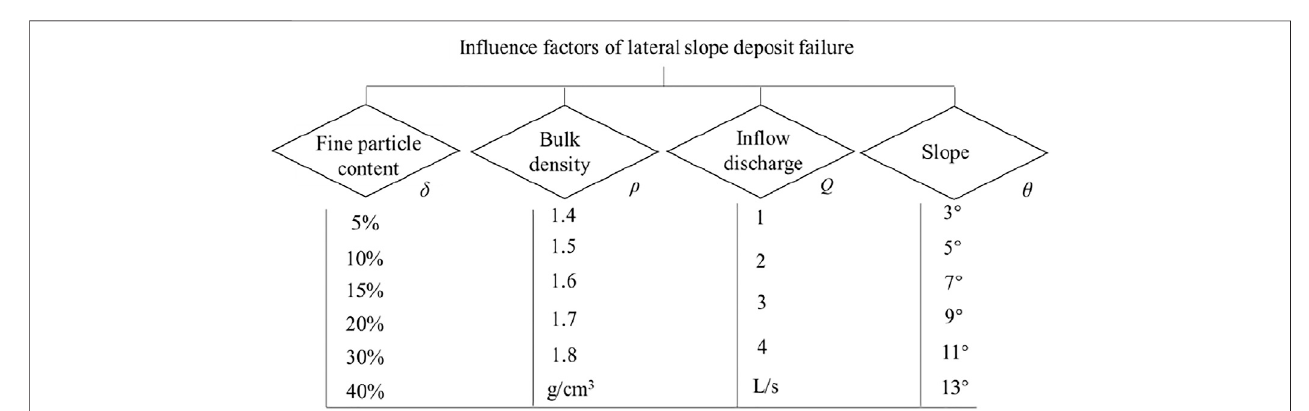
FIGURE 2 | In fl uence factors of lateral slope deposit failure considered in this study.